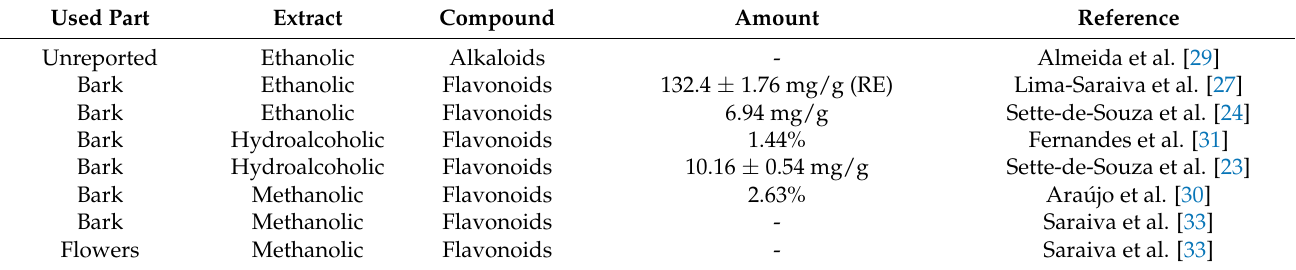
Table 2. Phytochemical compounds found in Schinopsis brasiliensis